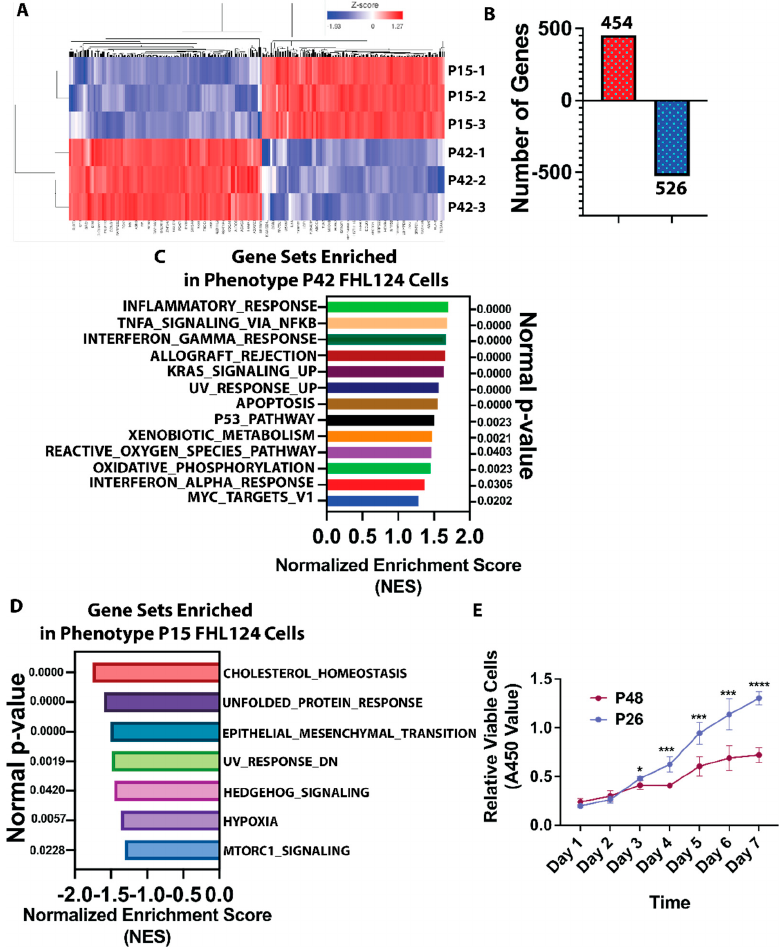
Figure 2. Aging alters LEC gene expression and decelerates LECs’ proliferation. Passage 15 (n = 3) and passage 42 (n = 3) FHL124 cells were used for RNAseq, and normalized transcriptomes were comparatively analyzed between P42 and P15 cells. ( A ) RNAseq heatmap showing the top 1000 genes differentially expressed in passage 42 and passage 15 FHL124 cells. ( B ) When comparing P42 to P15, differential gene expression (DGE) analysis revealed that 454 genes were upregulated, and 526 genes were downregulated more than 2-fold with both p -value and false discovery rate (FDR) less than 0.05. ( C ) GSEA (gene set enrichment analysis) identified 13 top-ranked pathways enriched in P42 passage FHL124 cells with a nominal p -value less than 0.05 and FDR below 5%. The pathways were ranked by normalized enrichment score (NES). ( D ) GSEA using MSigDB canonical pathway identified 7 top-ranked pathways enriched in P15 passage FHL124 cells with a nominal p -value less than 0.05 and FDR below 15%. The pathways were ranked by normalized enrichment score (NES). ( E ) Seven-day cell proliferation curve of both P26 and P48 passage FHL124 cells was assayed by CCK8 (n = 8 at each data point). Results in E are expressed as mean ± SD and were analyzed using 2-way ANOVA with Holm–Šídák’s multiple-comparisons test. Only p < 0.05 is considered significant. * < 0.05, ** < 0.01, *** < 0.001, **** < 0.0001.